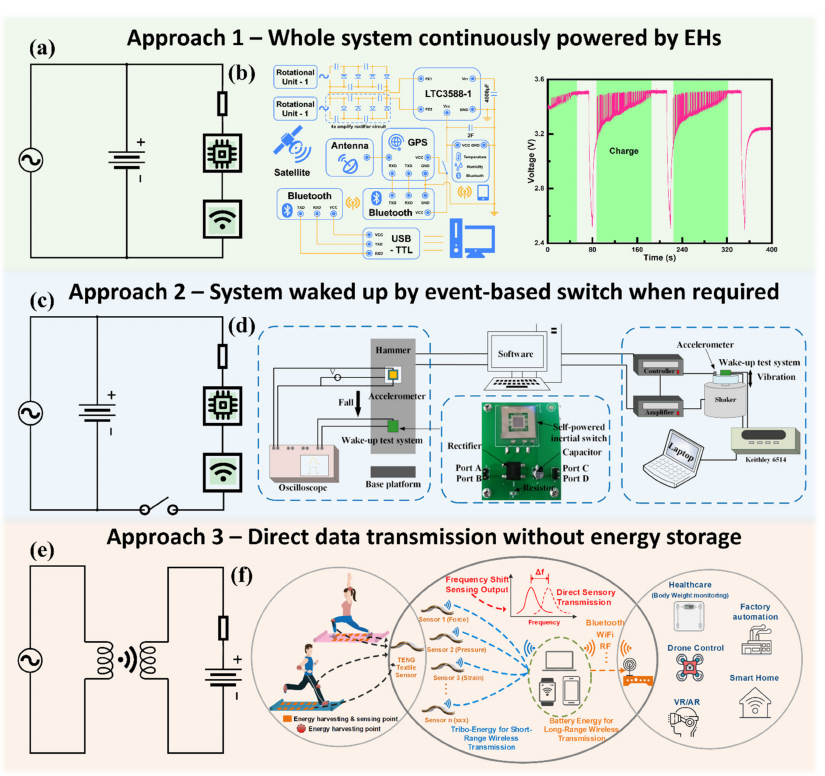
Figure 3. Three Approaches Toward Self-Sustainable IoT System: ( a , b ) approach 1—whole sys- tem continuously powered by EHs, (Reprinted with permission from ref. [166]. Copyright 2021 American Chemical Society); ( c , d ) approach 2—system waked up by event-based switch